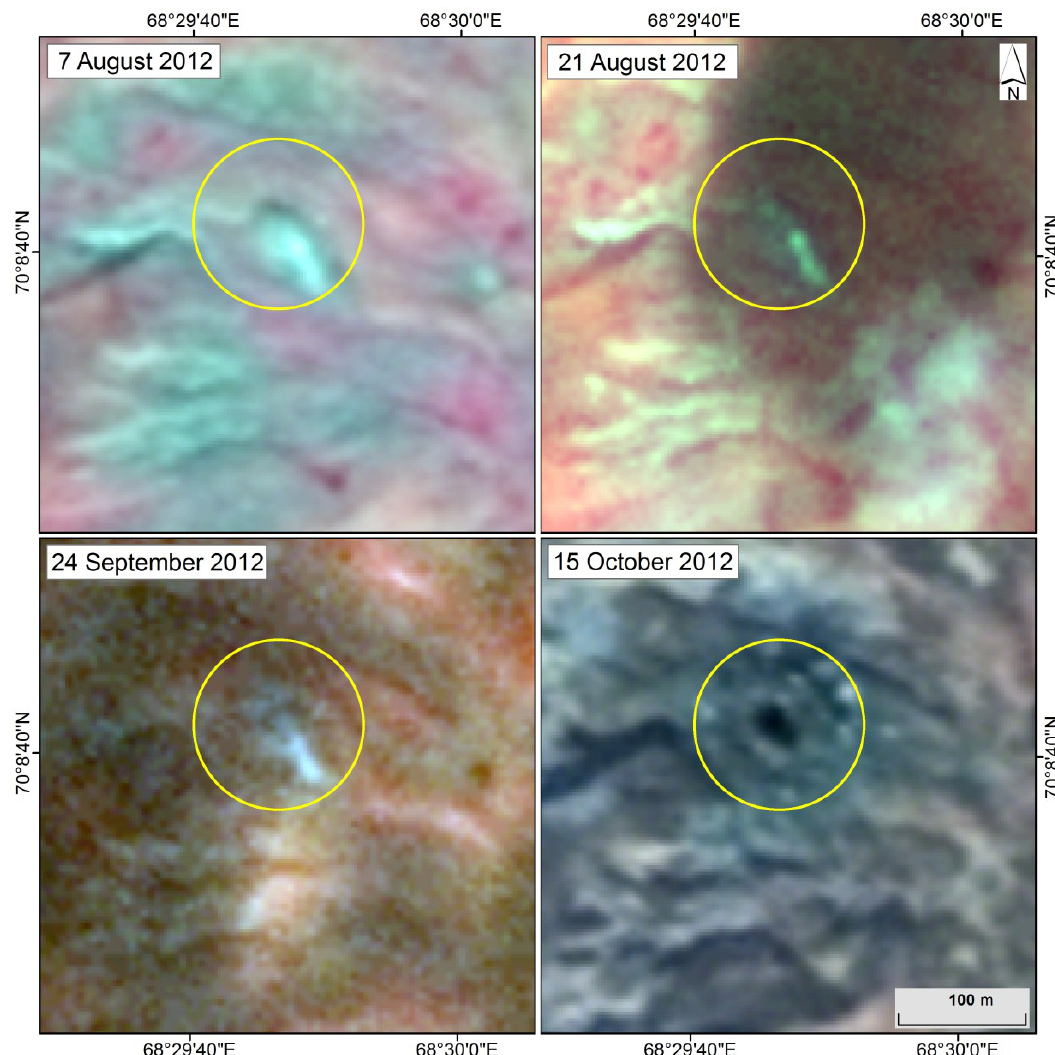
Figure 2. The time range of GEC-2 formation determined using SPOT5 data time series. Outlined is the area where changes in place of the mound-predecessor were observed. GEC-2 appeared between 24th September and 15th October 2012.